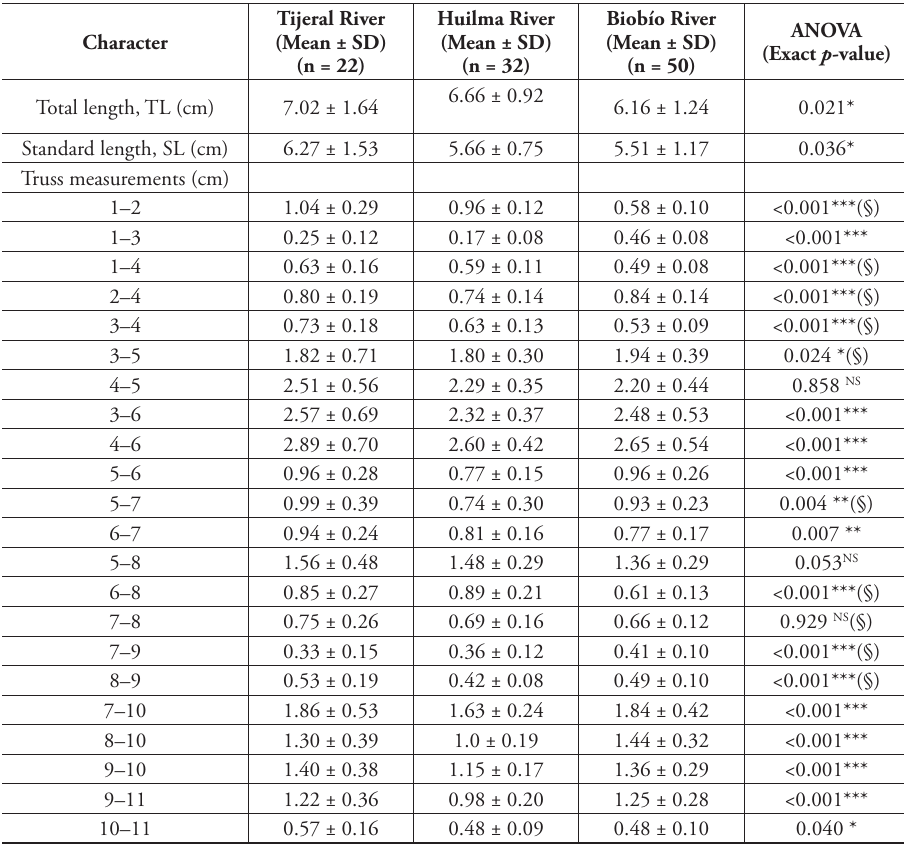
Table 1. Morphometric data for 24 characters of three Trichomycterus areolatus populations from southern